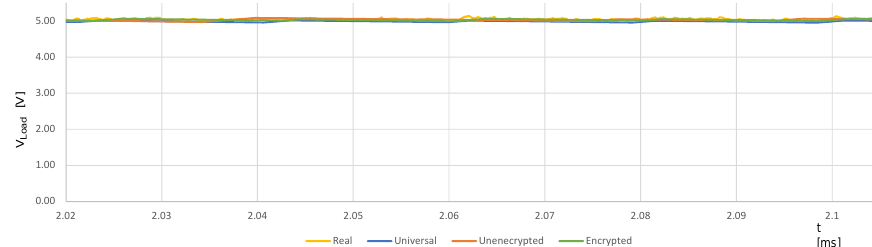
Figure 20. V Load models and real measurement time graph curves.